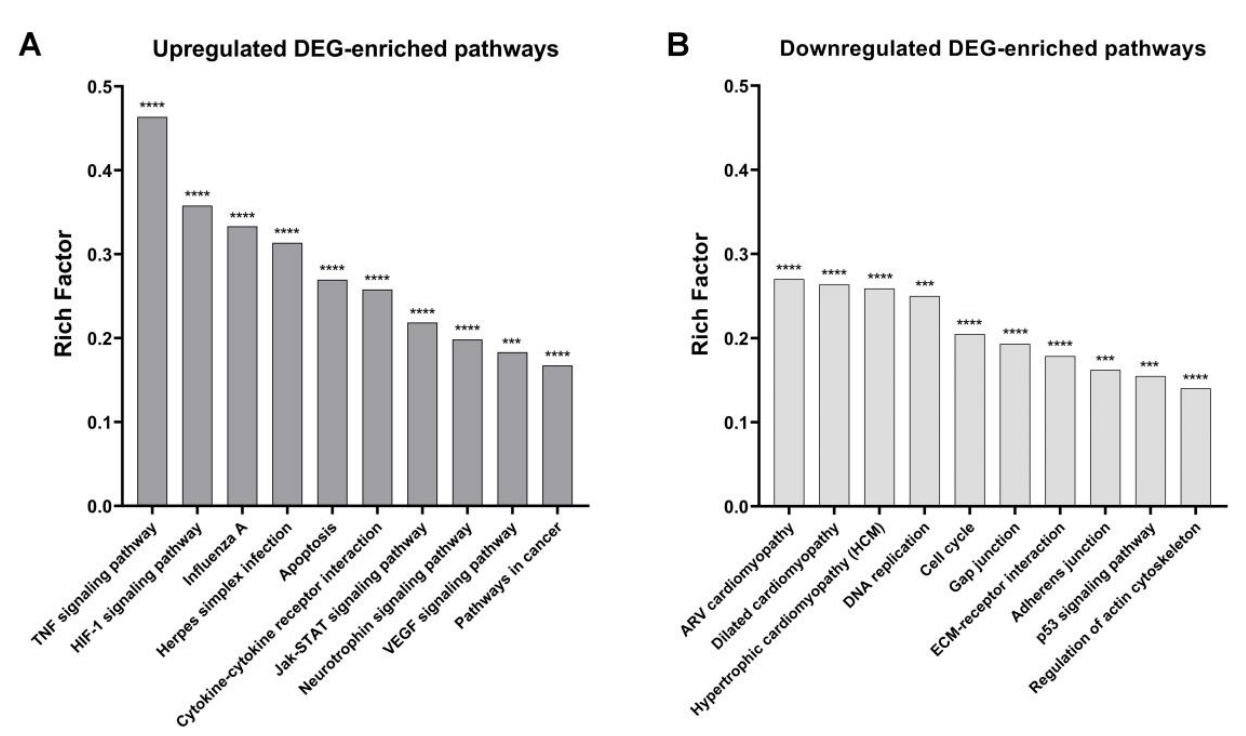
Figure 5. KEGG pathway analysis. Biological pathways enriched with DEGs resulting from the comparison M1 vs. D10. The x -axis represents the selected biological pathways from the KEGG database and the y -axis represents the rich factor, which is the result of the ratio between the number of DEG annotated with a given pathway in our dataset over the number of genes related to that pathway in the database. ( A ) Top RF biological pathways enriched with upregulated DEG. ( B ) Top RF biological pathways enriched with downregulated DEG. Asterisks represent the statistical value based on the corrected p -value resulting from the hypergeometric test (**** indicates p (adj) < 0.0005; *** indicates p (adj) < 0.005). Abbreviations: RF: rich